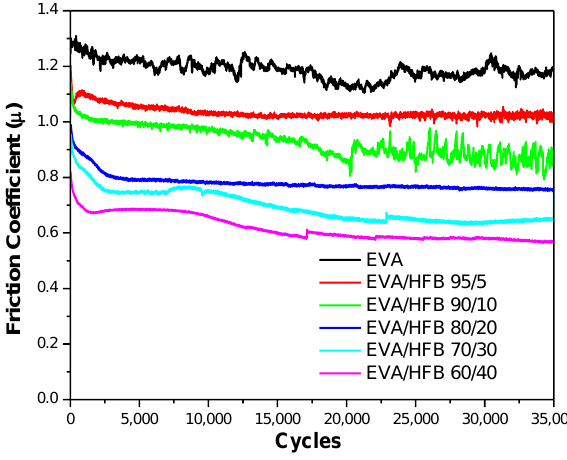
Figure 8. Friction coefficient of EVA and its composites. Table 4. Coefficients of friction (COF) and specific wear rates for EVA and its composites in a dry condition. Sample